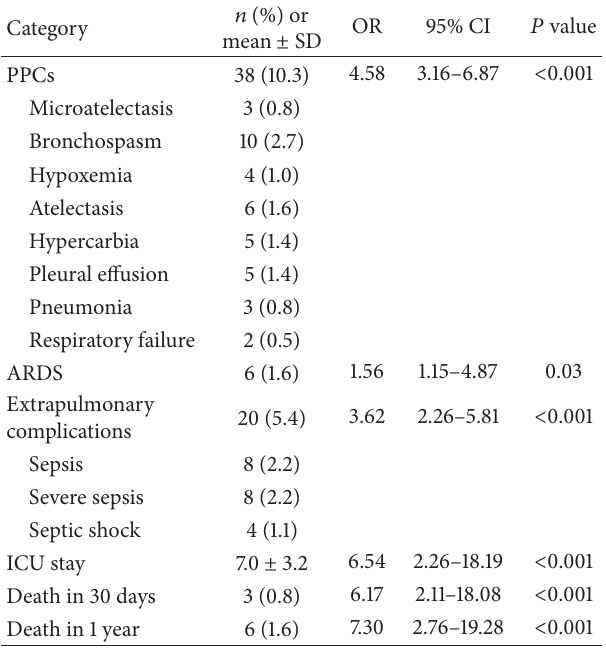
Table 4: Distribution of primary and secondary endpoints during 1- year follow-up and their relationships with miRNA-21 fold changes based on univariate logistic